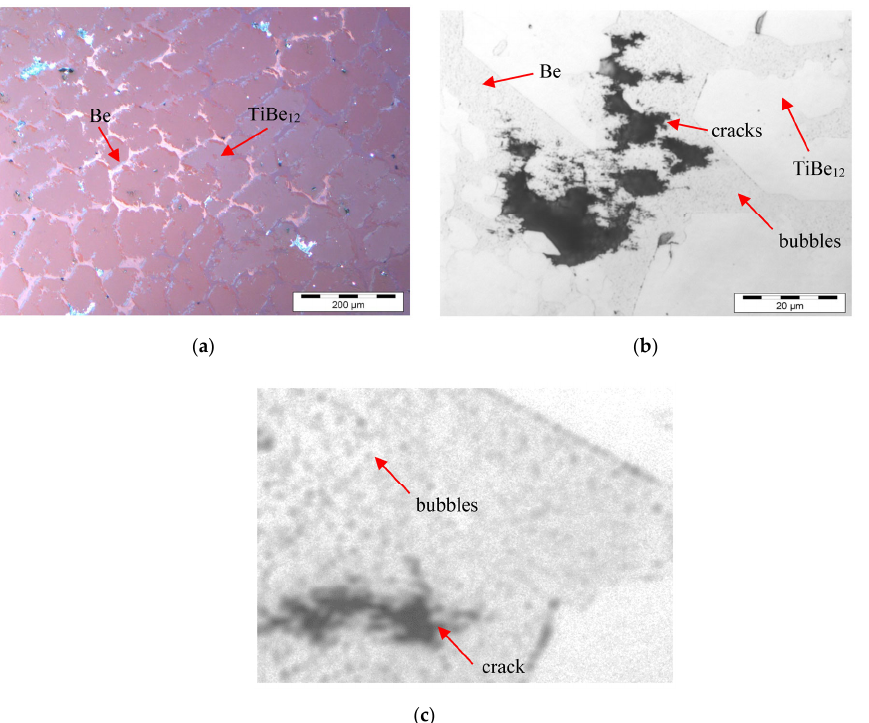
Figure 10. Two ‐ phase microstructure of cast Be ‐ 7Ti irradiated at 517 °C to neutron fluence of Figure 10. Two-phase microstructure of cast Be-7Ti irradiated at 517 ◦ C to neutron fluence of 1.51 · 1.51 ∙ 10 22 cm − 2 (E > 1 MeV) ( a ) and at 750 °C to neutron fluence of 1.82 ∙ 10 22 cm − 2 (E > 1 MeV) ( b ). View 10 22 cm − 2 (E > 1 MeV) ( a ) and at 750 ◦ C to neutron fluence of 1.82 · 10 22 cm − 2 (E > 1 MeV) ( b ). View of bubbles from picture ( b ) at higher magnification ( c ) (optical microscopy). of bubbles from picture ( b ) at higher magnification ( c ) (optical